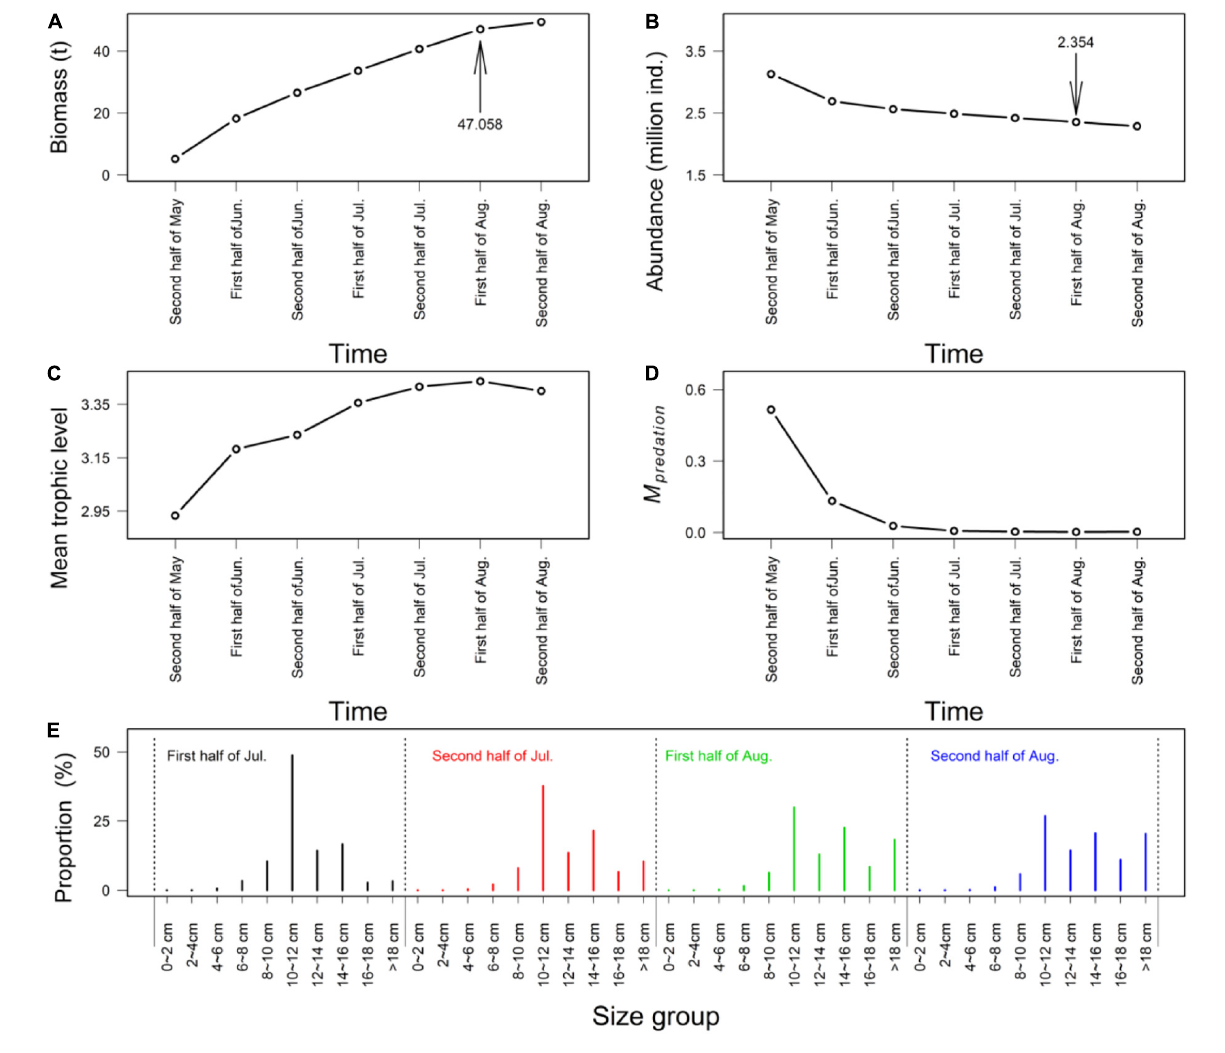
FIGURE 3 | The outputs of biomass (A) , abundance (B) , mean trophic level (C) , predation mortality (D) , and mean size of population (E) for F. chinensis in 2012. (A–D) showed the variations of biomass, abundance, metatrophic level, and predation mortality from the end of May (time step 9) and the end of August (time step 15). (E) showed the variations of size structure in population within July and August (time steps 12 ∼